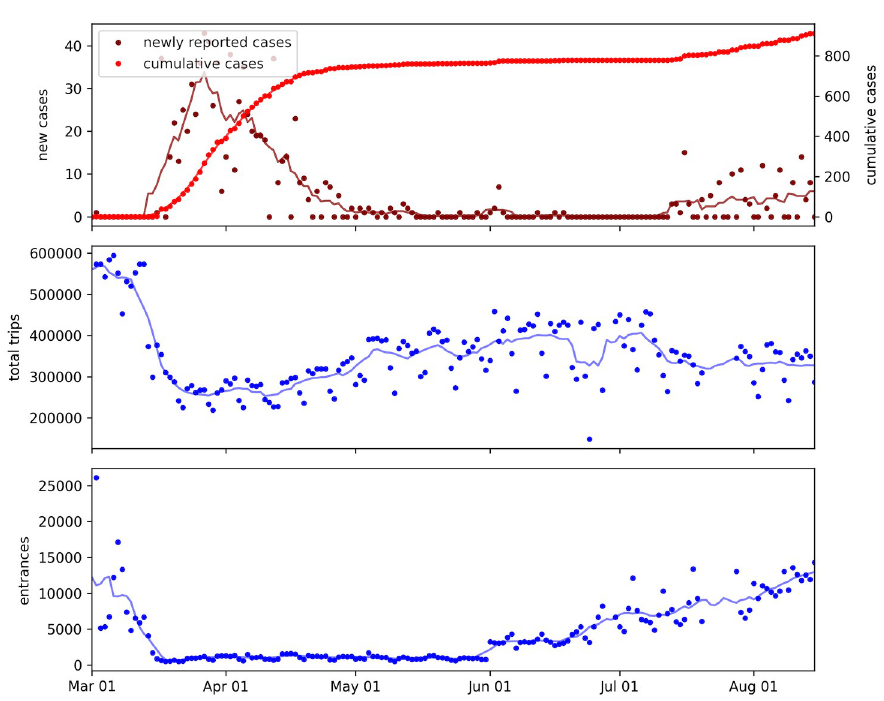
Fig 1. Daily reported cases, trips, and entrances metrics at the start of the COVID-19 pandemic in Andorra. The time series data are plotted for March to August, 2020, which covers the study period. Solid lines show values smoothed over a 7-day rolling